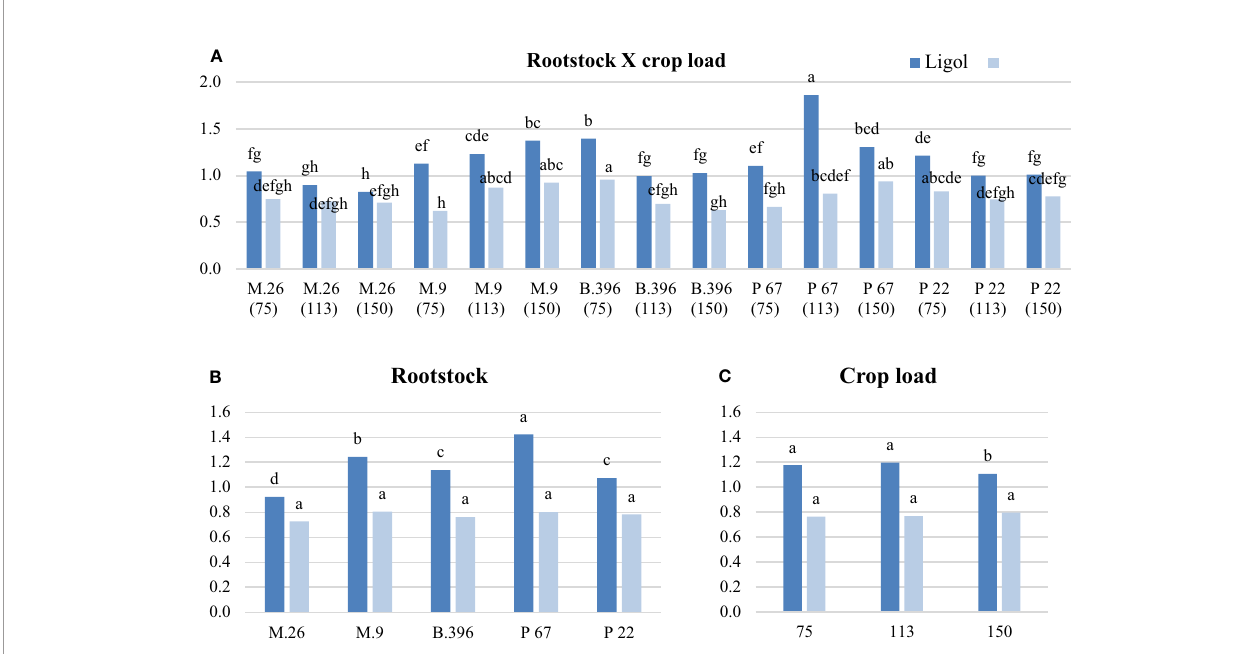
FIGURE 1 | The effect of rootstock (B) and crop load (C) interaction (A) on the ratio of fl owering promoters to inhibitors phytohormones in “ Ligol ” and “ Auksis ” buds. *The different letters on bars of same cultivar indicate signi fi cant differences. The analysis was conducted with all data resulting from 9 trees of “ Ligol ” and “ Auksis ” apple tree grafted on M.26, M.9, B.396, P 67, and P 22, with crop-load adjusted to 75, 113, and 150 fruits per tree. The data were processed using analysis of variance (ANOVA), the Turkey (HSD) multiple range test at the con fi dence level p = 0.05. Promoters — zeatin and jasmonic acid; Inhibitors — indolyl-3 acetic acid; abscisic acid; gibberellins (GA 7 , GA 3 , GA 1